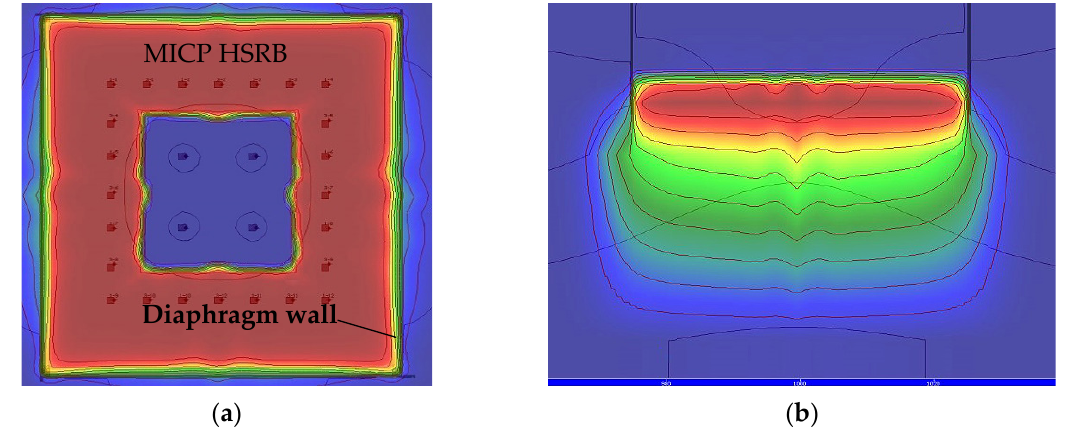
Figure 21. Migration of S. pasteurii in condition 8: ( a ) Horizontal; ( b ) Vertical.